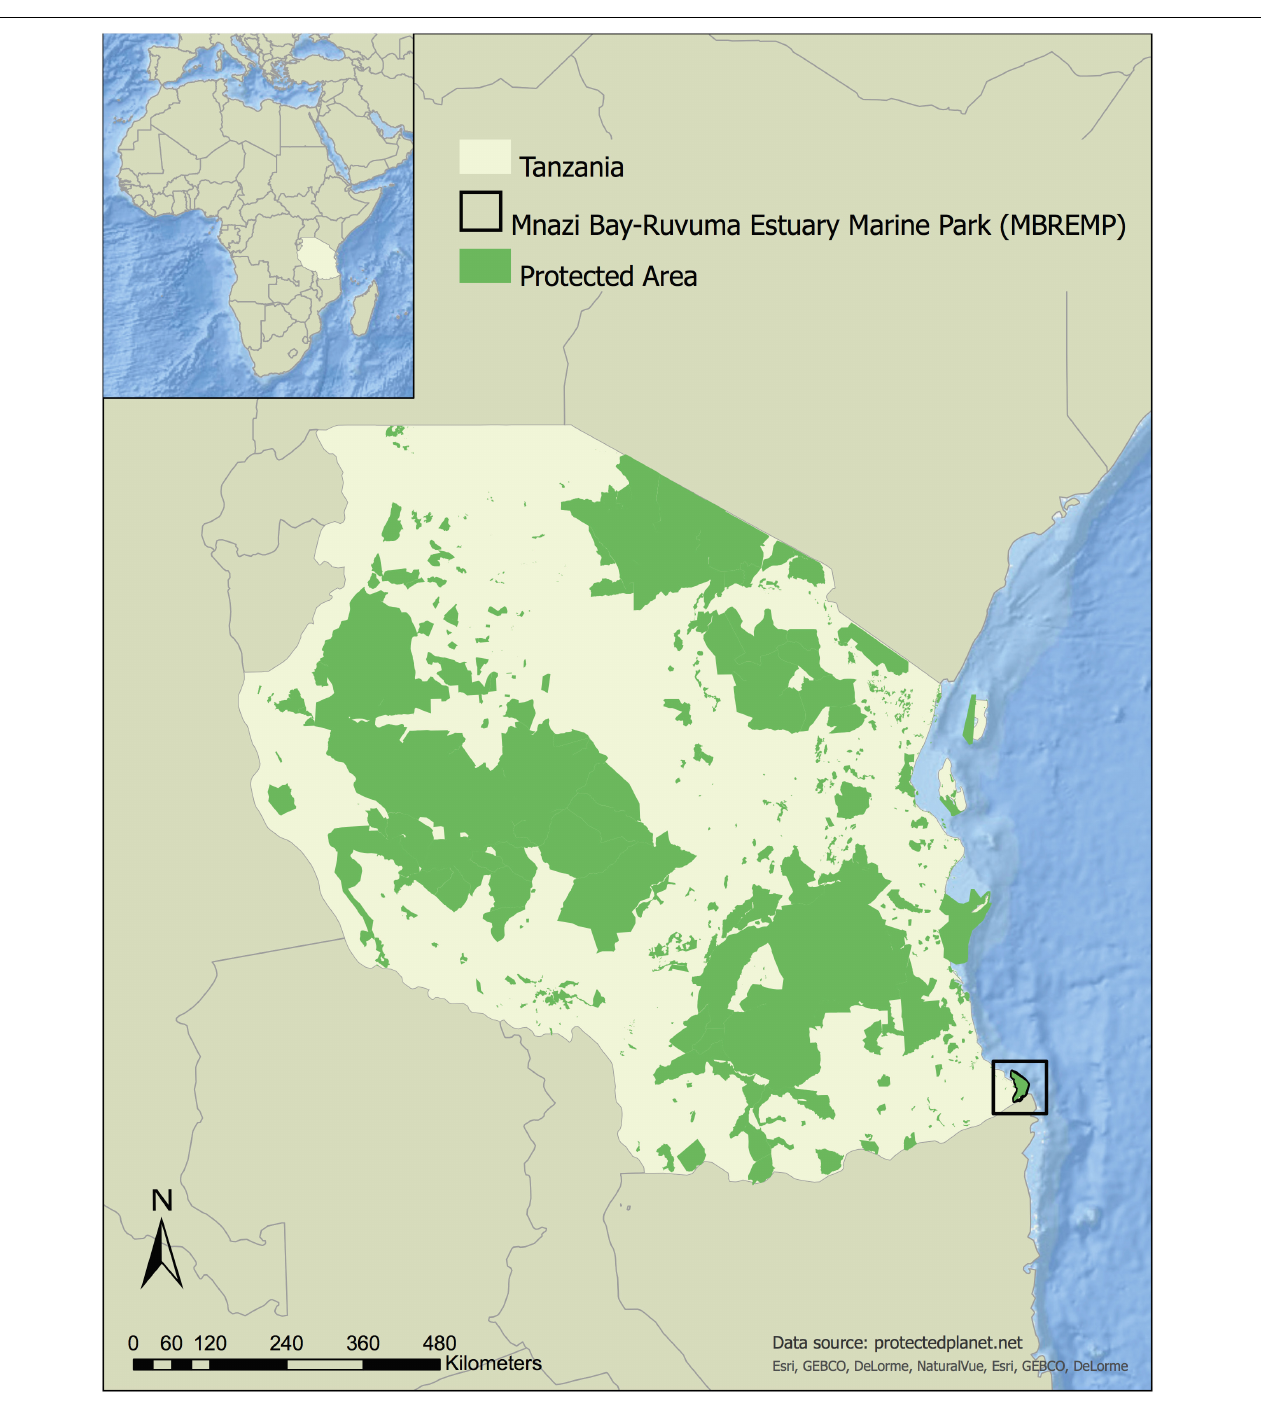
FIGURE 1 | Map of Tanzania, located in East Africa, illustrating geographic extent of protected area coverage across the country. MBREMP is located along the southern border with Mozambique. Data obtained from the World Database on Protected Areas (UNEP-WCMC et al.,